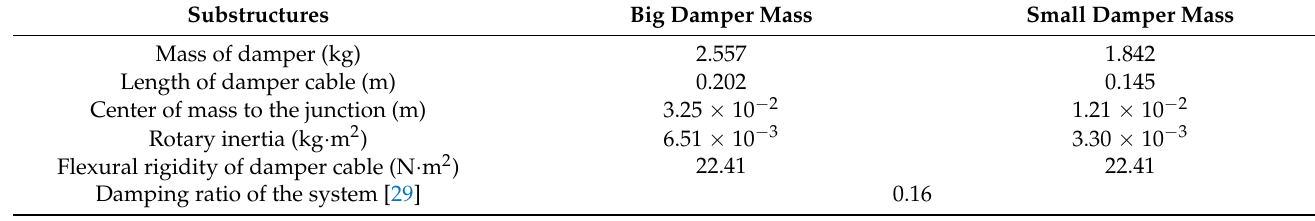
Figure 22. FR-3 Stockbridge damper. (Left: Small damper mass. Right: Big damper mass.)